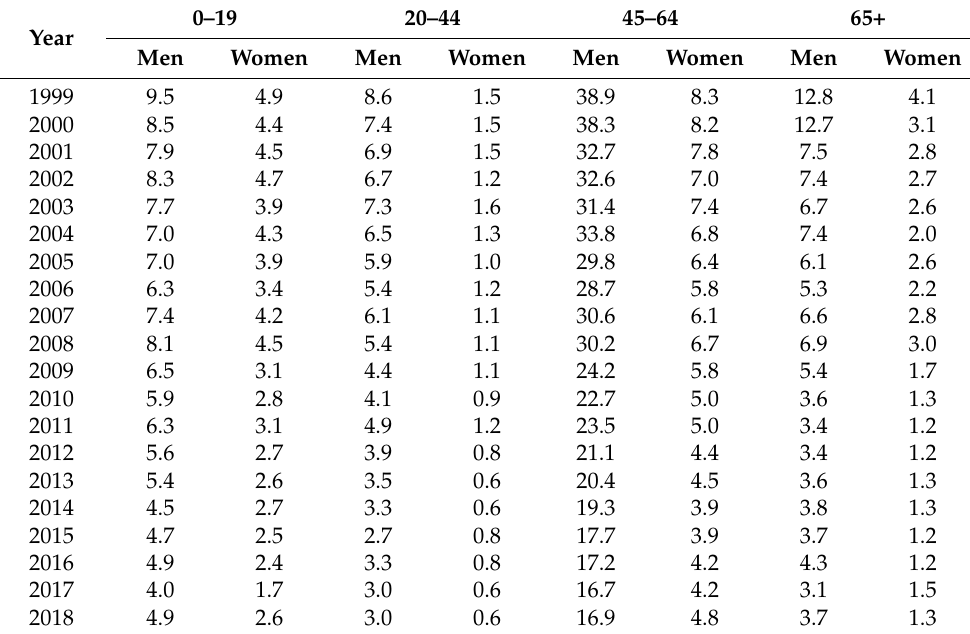
Table 3. Standardized death rates due to road traffic injured by sex in 1999 − 2018 in Poland according to age groups.